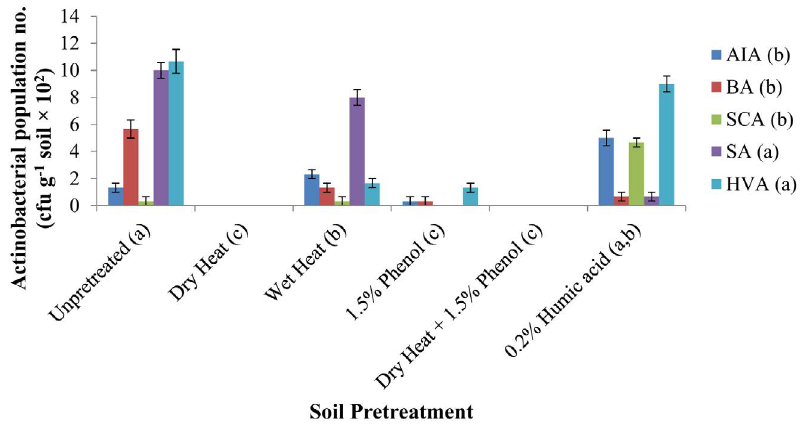
Fig.1. Recovery of actinobacteria from different pretreated soil samples on different selective media. (AIA, Actinomycete Isolation Agar; BA, Bennett’s Agar; SCA, Starch Casein Agar; SA, Streptomyces Agar; HVA, Humic acid Vitamin Agar. Different lower case letters within parenthesis were significantly different among different pretreatments and among different selective media at p<0.05. Vertical bars represent standard error of